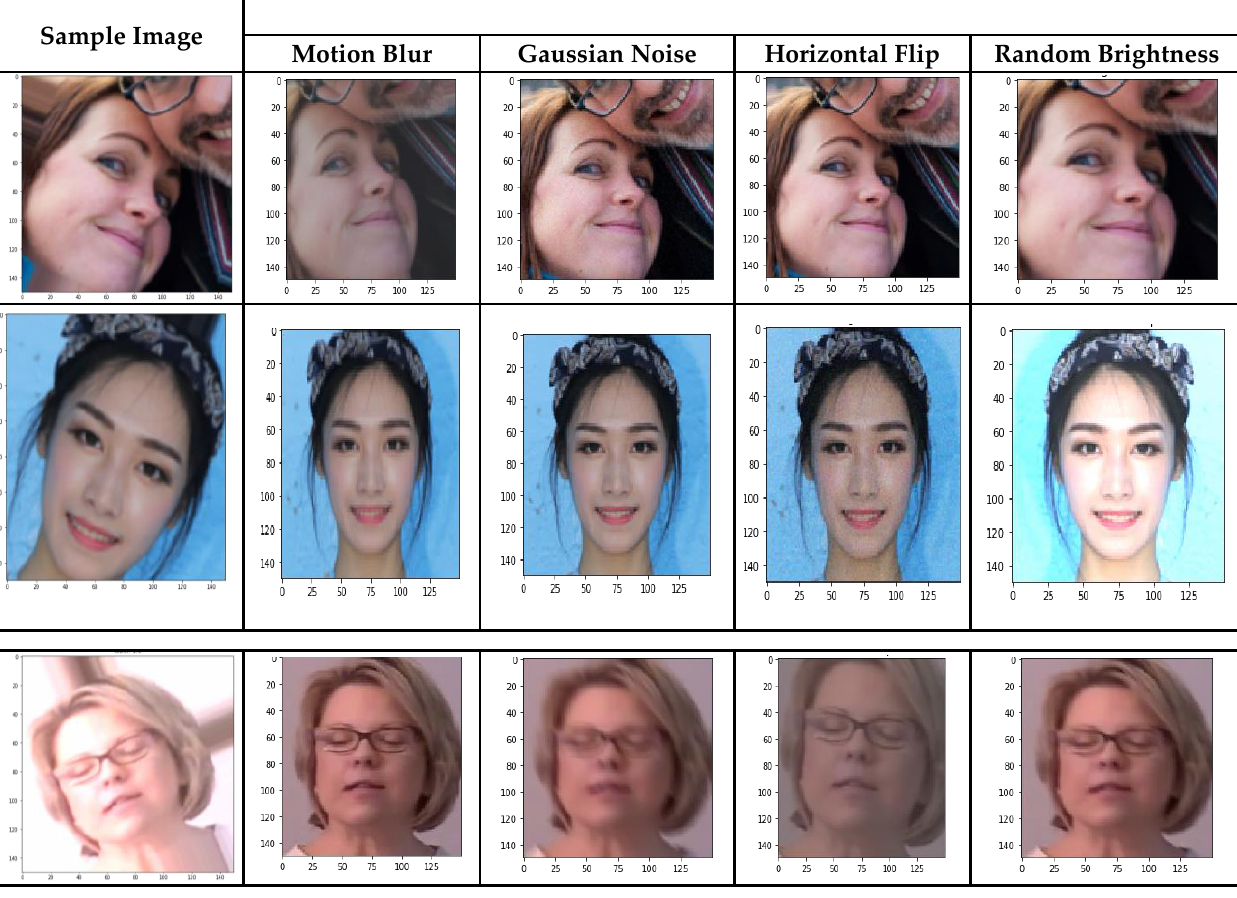
Figure 2. Examples of image augmentation.